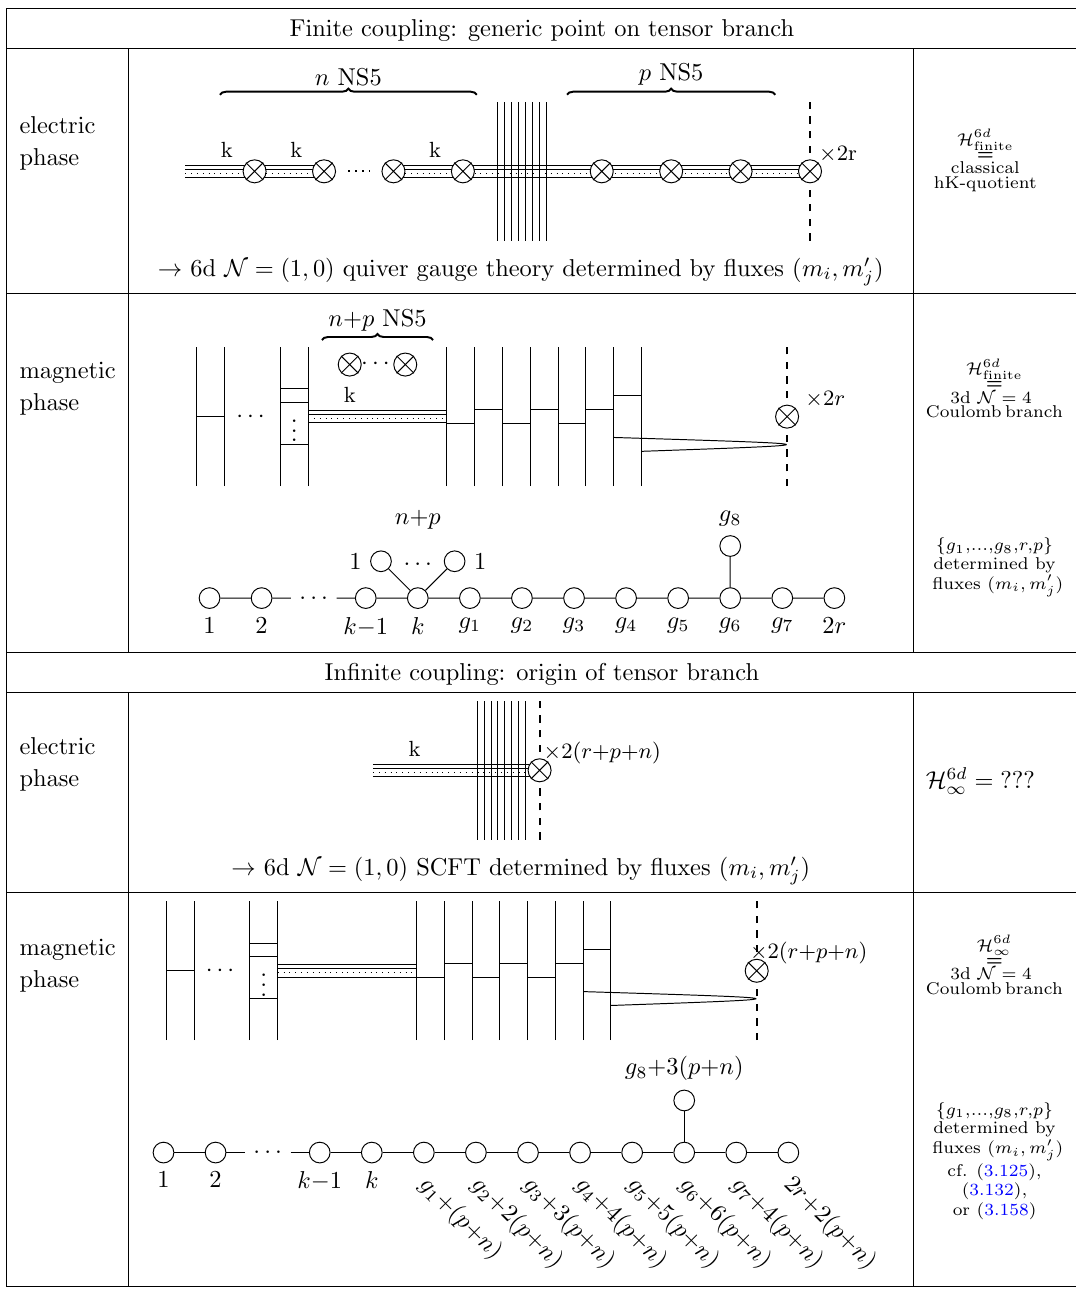
Table 3 . Contrasting the electric and magnetic description of the Higgs branch on a generic point and the origin of the tensor branch. The diagrams are schematics for the general cases discussed in section 3.6. A given embedding Z k , ! E 8 , labeled by (cid:13)uxed ( m i ; m 0 con(cid:12)gurations and the resulting magnetic quivers.